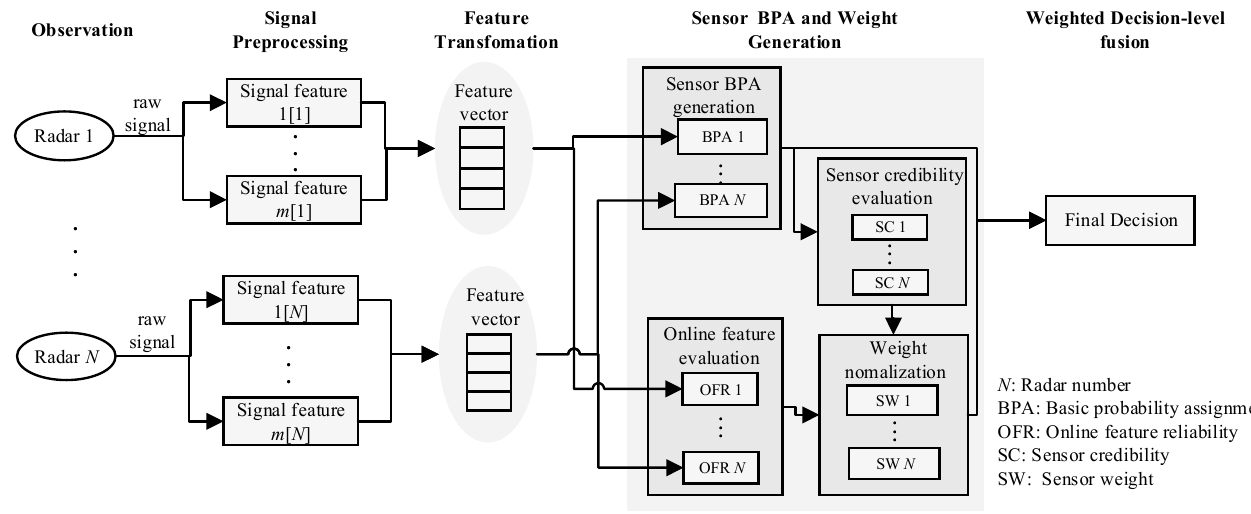
Figure 8. The workflow of our proposed multi-sensor fusion architecture for ballistic target classi- fication.